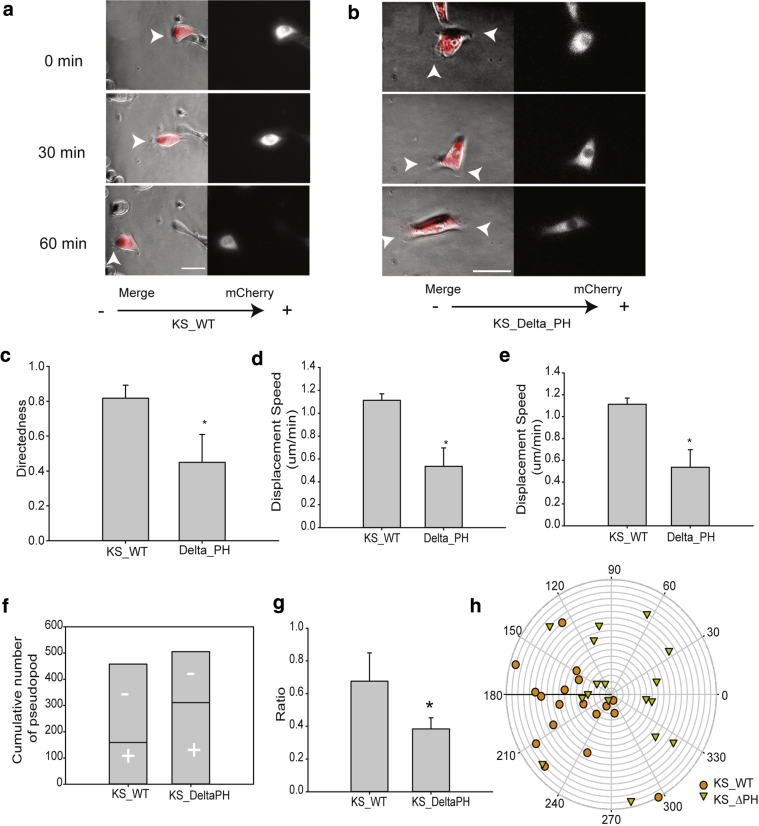
The Kindlin-1 PH domain is required for electrotactic response of keratinocytes. KS_WT and PH domain-deleted KS_Delta_PH cells were treated with 200 mV/mm for 1 hour. Representative time-lapse images show protrusion formation in (a) KS_WT and (b) KS_Delta_PH cells (see Supplementary Video S6). EF vector is horizontal, with cathode to the left. Arrowheads indicate protrusions. Graphs showing (c) directedness, (d) displacement speed, and (e) trajectory speed of cells as in c. The (f) cumulative number of pseudopods and ratio of (g) cathode-facing pseudopods and (h) pseudopod distribution are summarized. The – and + indicate cathode and anode, respectively. Results are presented as means ± standard error of the mean, n ≥ 3 experiments. ∗P < 0.05. Scale bar = 100 μm. KS_WT, Kindler syndrome cells infected with wild-type kindlin-1–mCherry; min, minute; PH, pleckstrin homology.